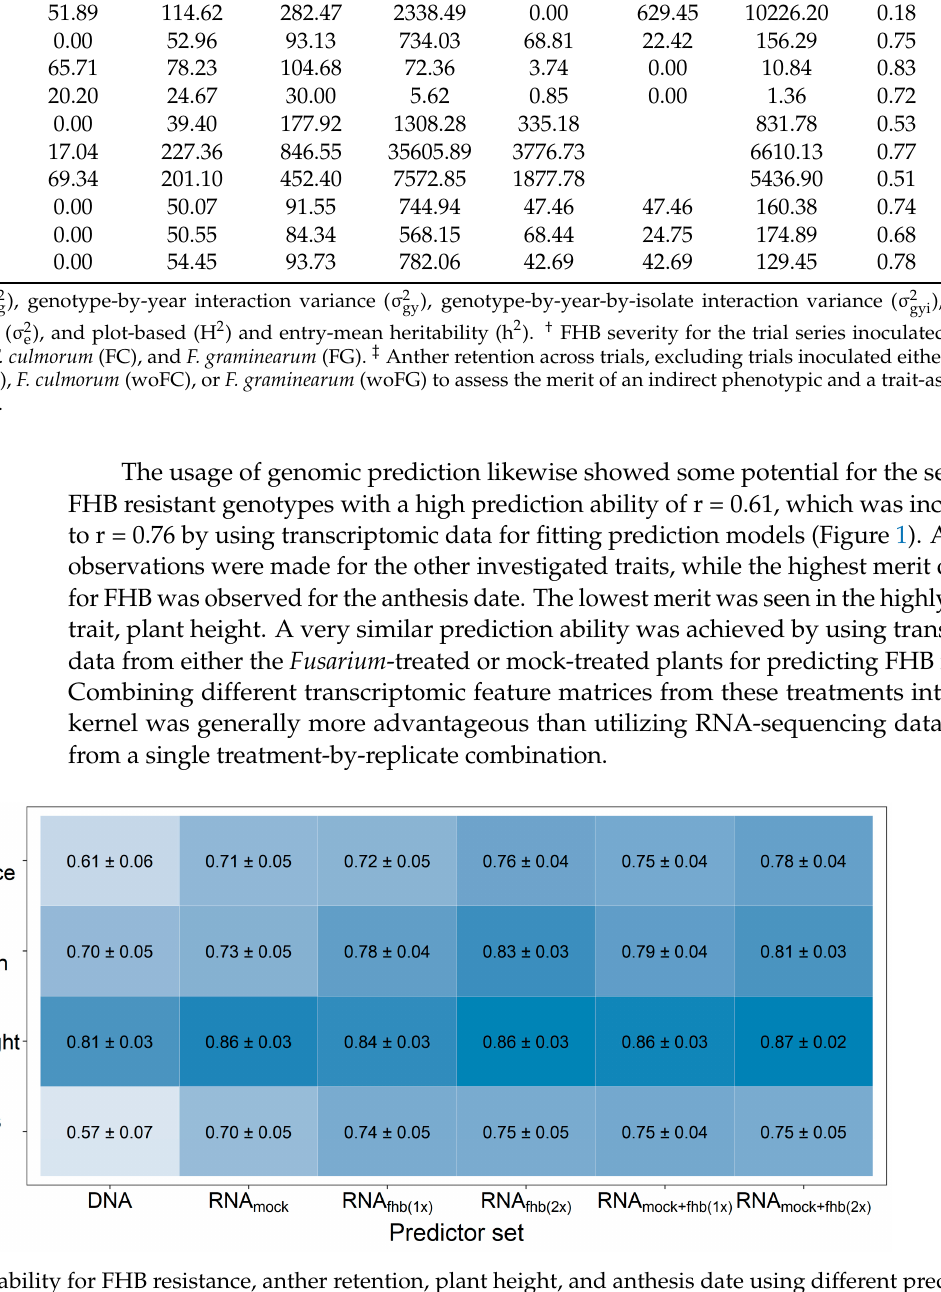
312 Figure 2. Average prediction ability using an increasing number of genomic and transcriptomic 313 predictors. The merit of molecular markers (DNA) for fitting prediction models was compared 314 with utilizing the individual feature matrices of the transcriptomic data obtained from mock- 315 treated plants (RNA mock ) or Fusarium -treated plants (RNA fhb(1x) ), a combination from both 316 Fusarium -treated replications (RNA fhb(2x) ) or from one mock-treated and one Fusarium -treated repli- 317 cate at time (RNA mock+fhb(1x) ) as well as an integration of gene expression data from all treatment-by- 318 replication combinations (RNA mock+fhb(2x) ). Darker coloring indicates a higher average prediction 319 ability. 320